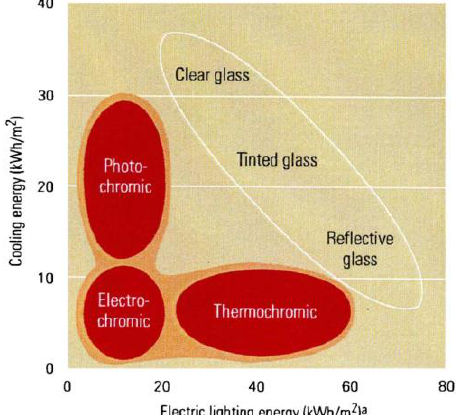
Figure 1. Comparison of electric lighting energy and cooling energy among di ff erent glazing typologies. Reprinted from “Progress in chromogenics: New results for electrochromic and thermochromic materials and devices”, Solar Energy Materials & Solar Cells 93 (2009) 2032–2039, Copyright (2009), with permission from